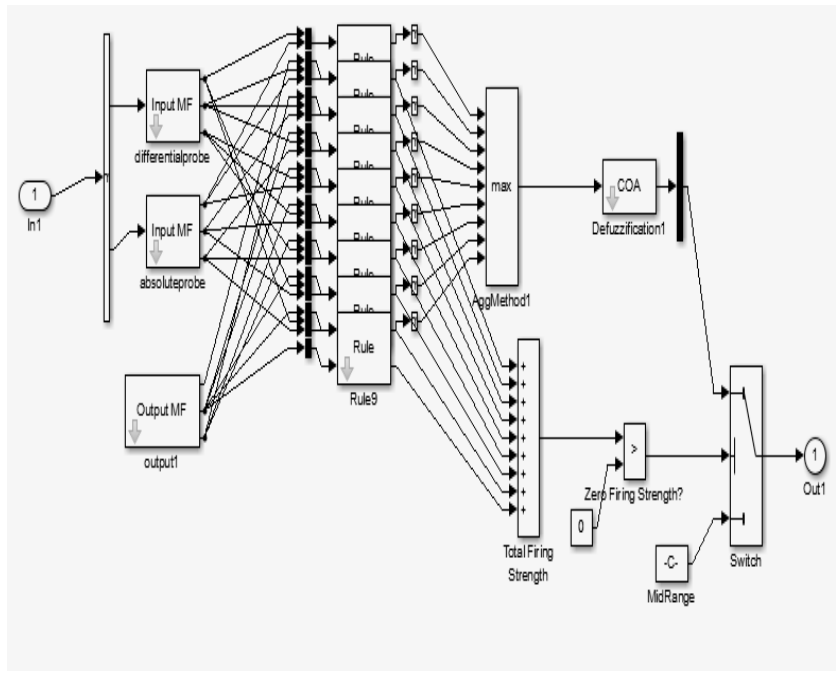
Figure 5. Basic block internal function in Fuzzy Logic.